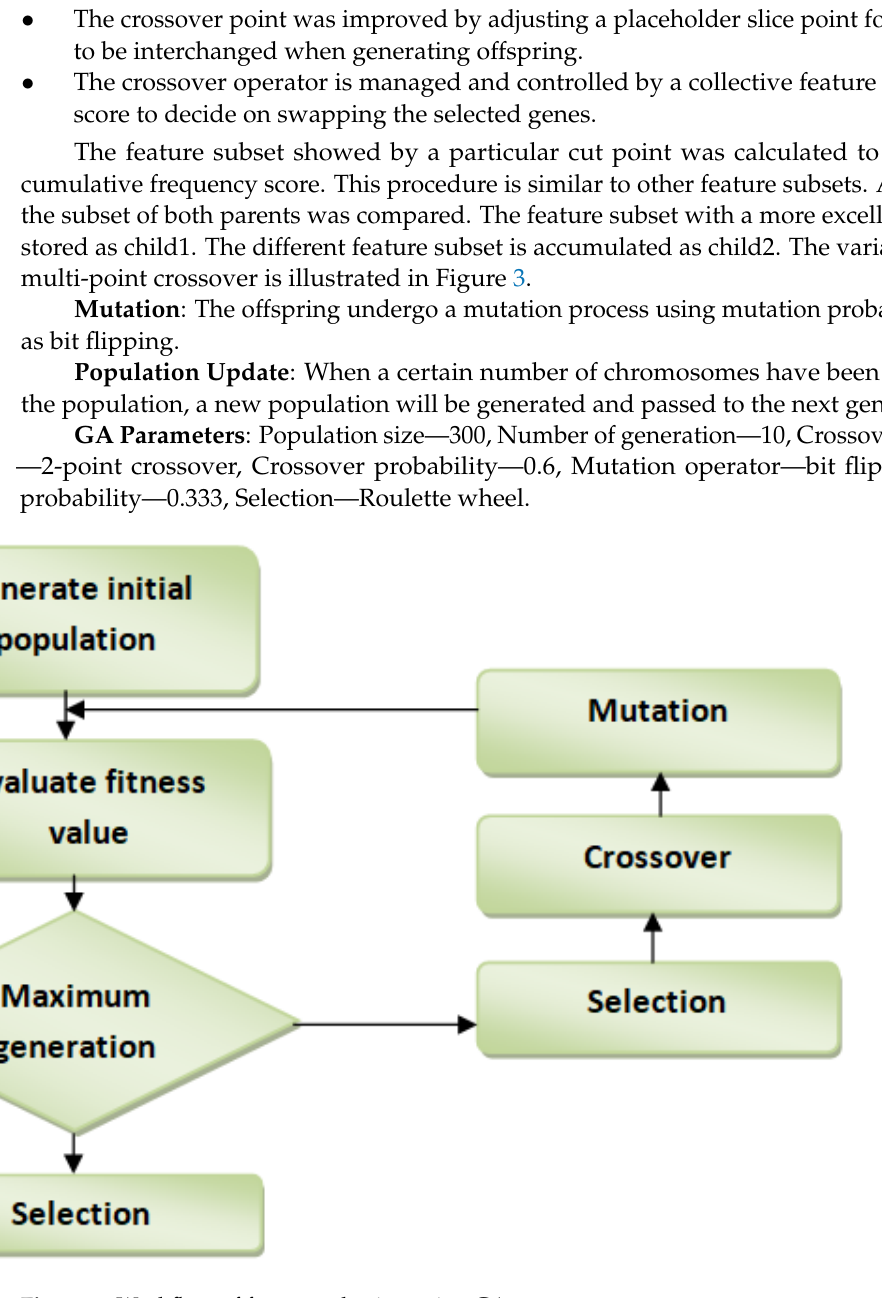
Figure 2. Workflow of feature selection using Figure 2: Workflow of feature selection using GA.